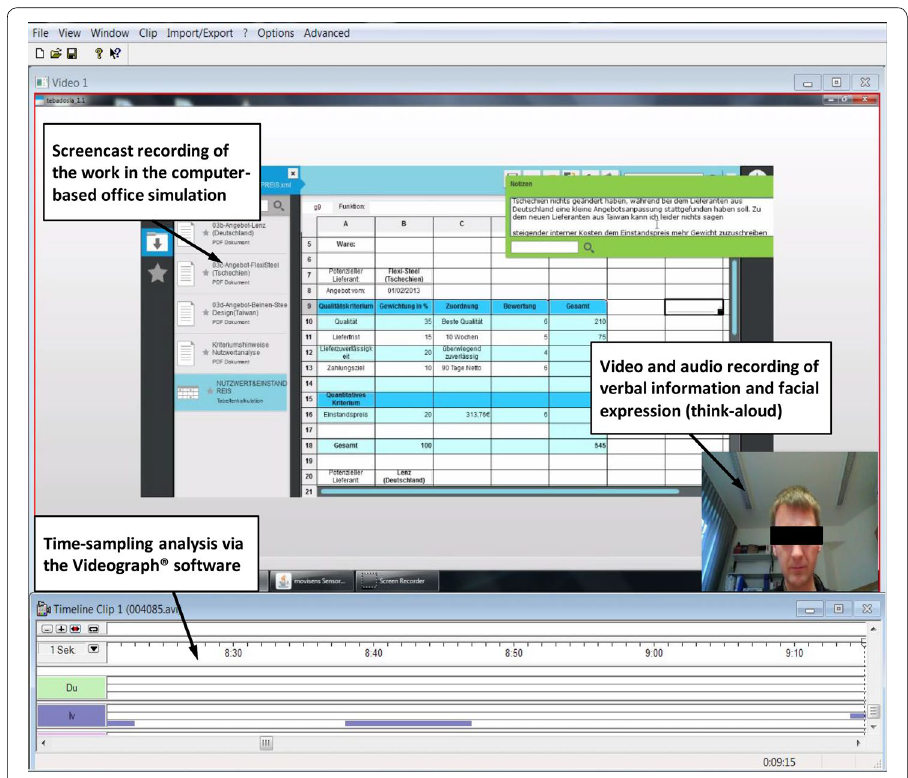
Fig. 2 Technical realization of screencast recording, think-aloud recording, and time-sampling